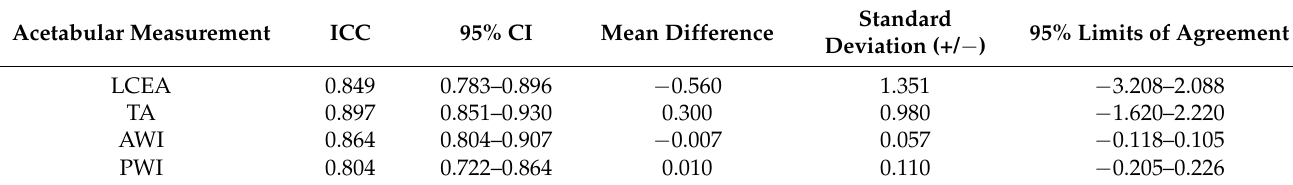
Table 1. Agreement between intraoperative fluoroscopy and postoperative radiograph ( n = 100). Acetabular Measurement